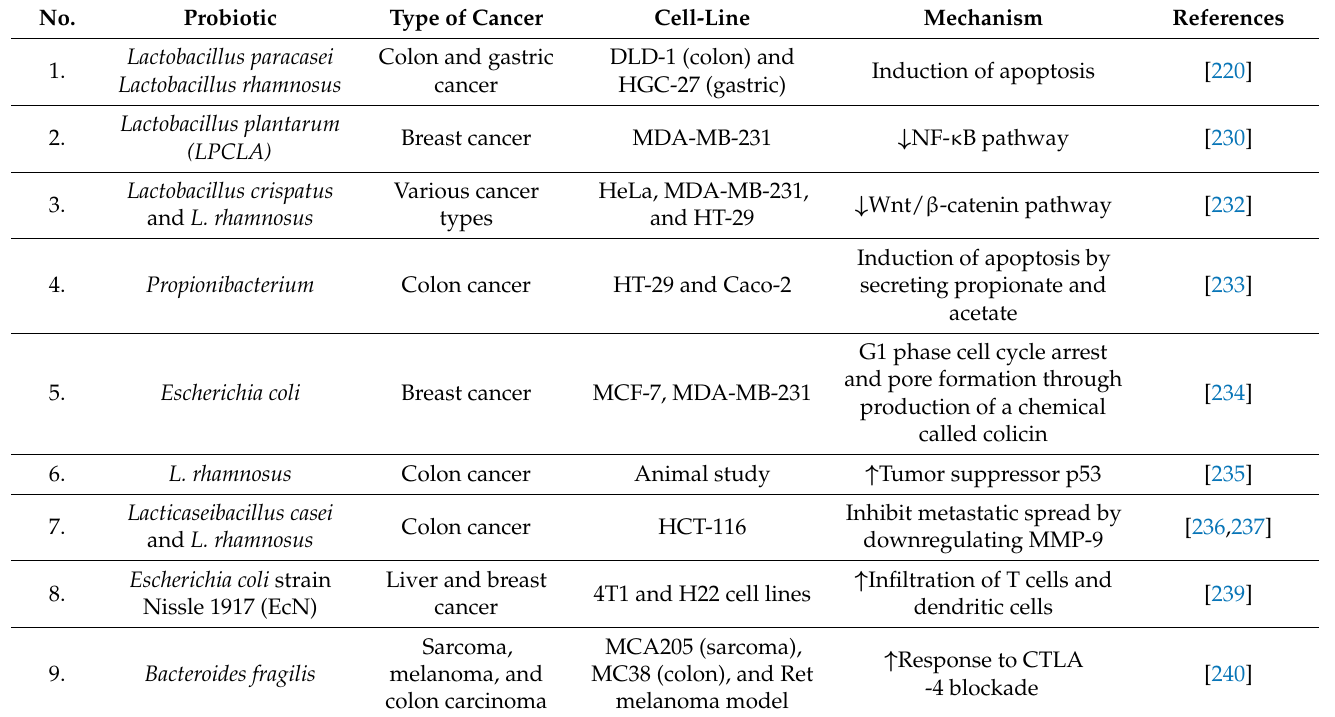
Table 2. Mechanisms of different probiotics used to treat